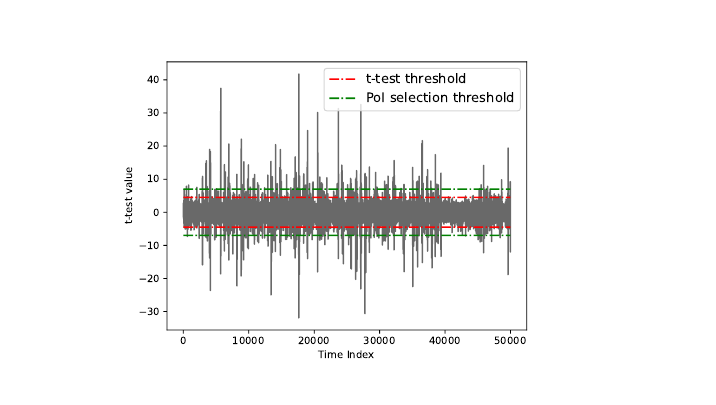
Figure 4: TVLA results for Kyber ( KYBER512 ) between G ( m ) = 0 and G ( m ) = 1 (greater than the ± 4 . 5), thus indicating a significant difference between the two sets of measurements at these peaks and we choose a threshold of ± 7 for PoI selection and construct reduced templates for each class. Thus, an attacker can classify a single EM trace from the FO transform into class m = 0 and m = 1 to realize an efficient plaintext checking oracle . This leakage comes directly from the FO transform and hence applies to multiple lattice-based KEMs that utilize the same to achieve IND-CCA